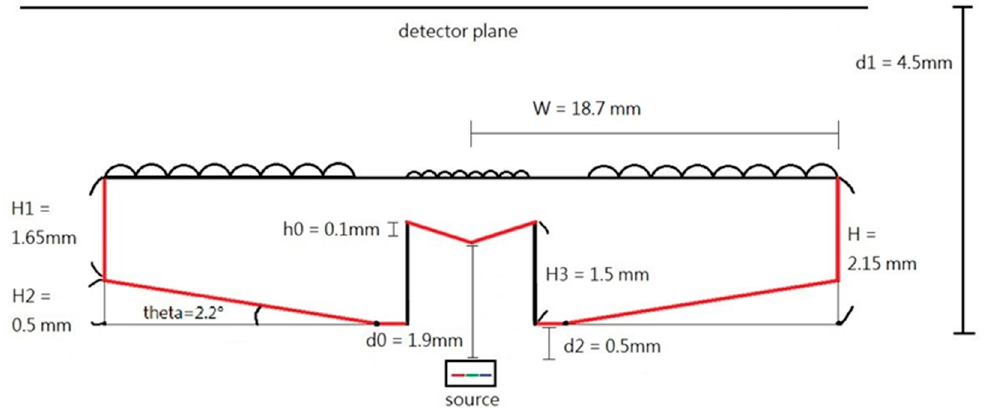
Figure 5. The side view of our final design. The surfaces, represented by red lines, are coated with metal.